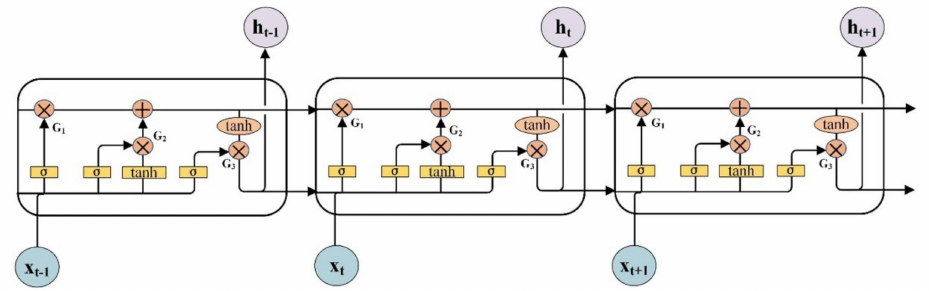
Figure 2. Schematic diagram of LSTM neural network